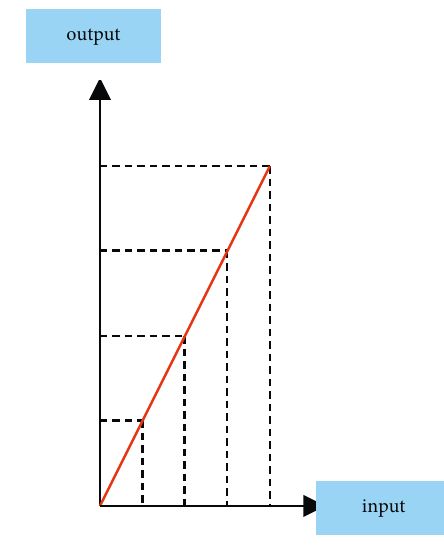
Figure 4: Grayscale linear transformation.